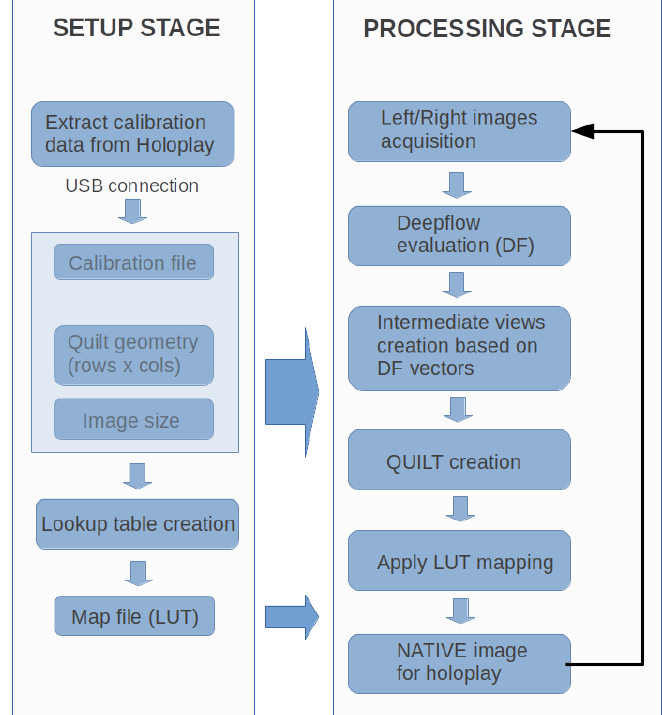
Figure 5. Flow diagram of the proposed algorithm starting from a stereoscopic image. A multi-view representation of a three-dimensional (3D) scene is obtained without using complex and expensive acquisitions via multiple cameras. LUT = Lookup